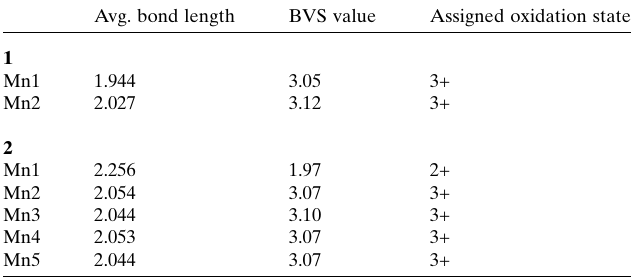
Table 1 Average bond-length (A˚ ) and bond-valence-sum (BVS) values (v. u.) used to support assigned oxidation states of the manganese ions of 1 and 2 .